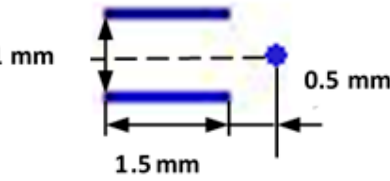
Figure 1. Trajectories of dynamic electron beam positioning.